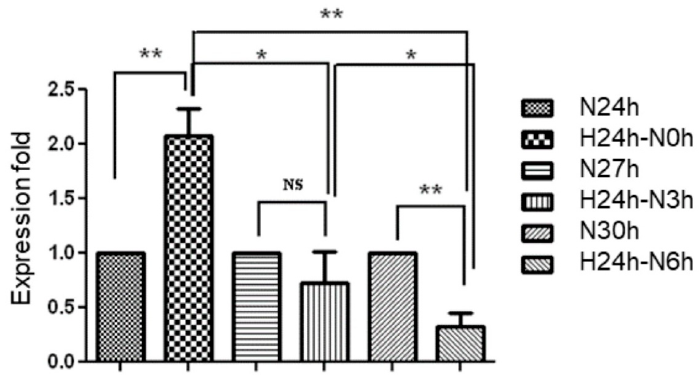
Figure 2. Evaluation of hsa-miR-21-5p expression in human umbilical vein endothelial cells (HUVEC). HUVEC was cultured at normoxia (N) and hypoxia (H) condition for different incubation periods including normoxia for 24 to 30 h (N24h to N30h), and hypoxia for 24 h then normorxia for 0 to 6 h (H24h–N0h to N6h). Data is shown as mean ± SEM from three independent experiments. * p < 0.05, ** p < 0.01, significant difference between two groups; NS, no significant difference.